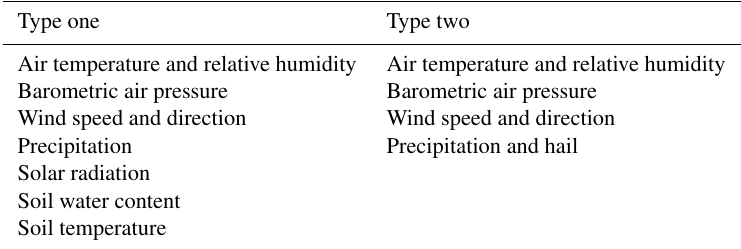
Figure 4. Typical station outline for station type one with the arrangement of sensors around the station area to avoid interferences or shadowing from other technical equipment. Table 1. Measured parameters for each station